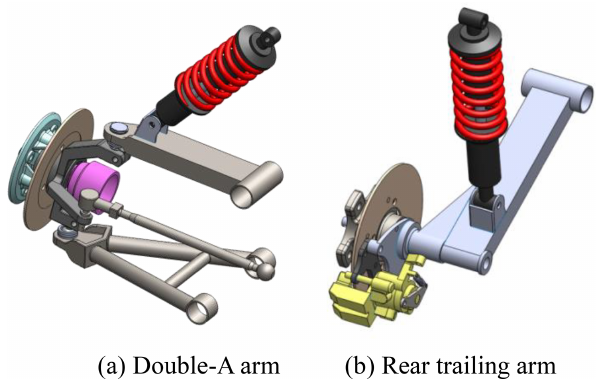
Figure 1. Front and rear suspension systems in target